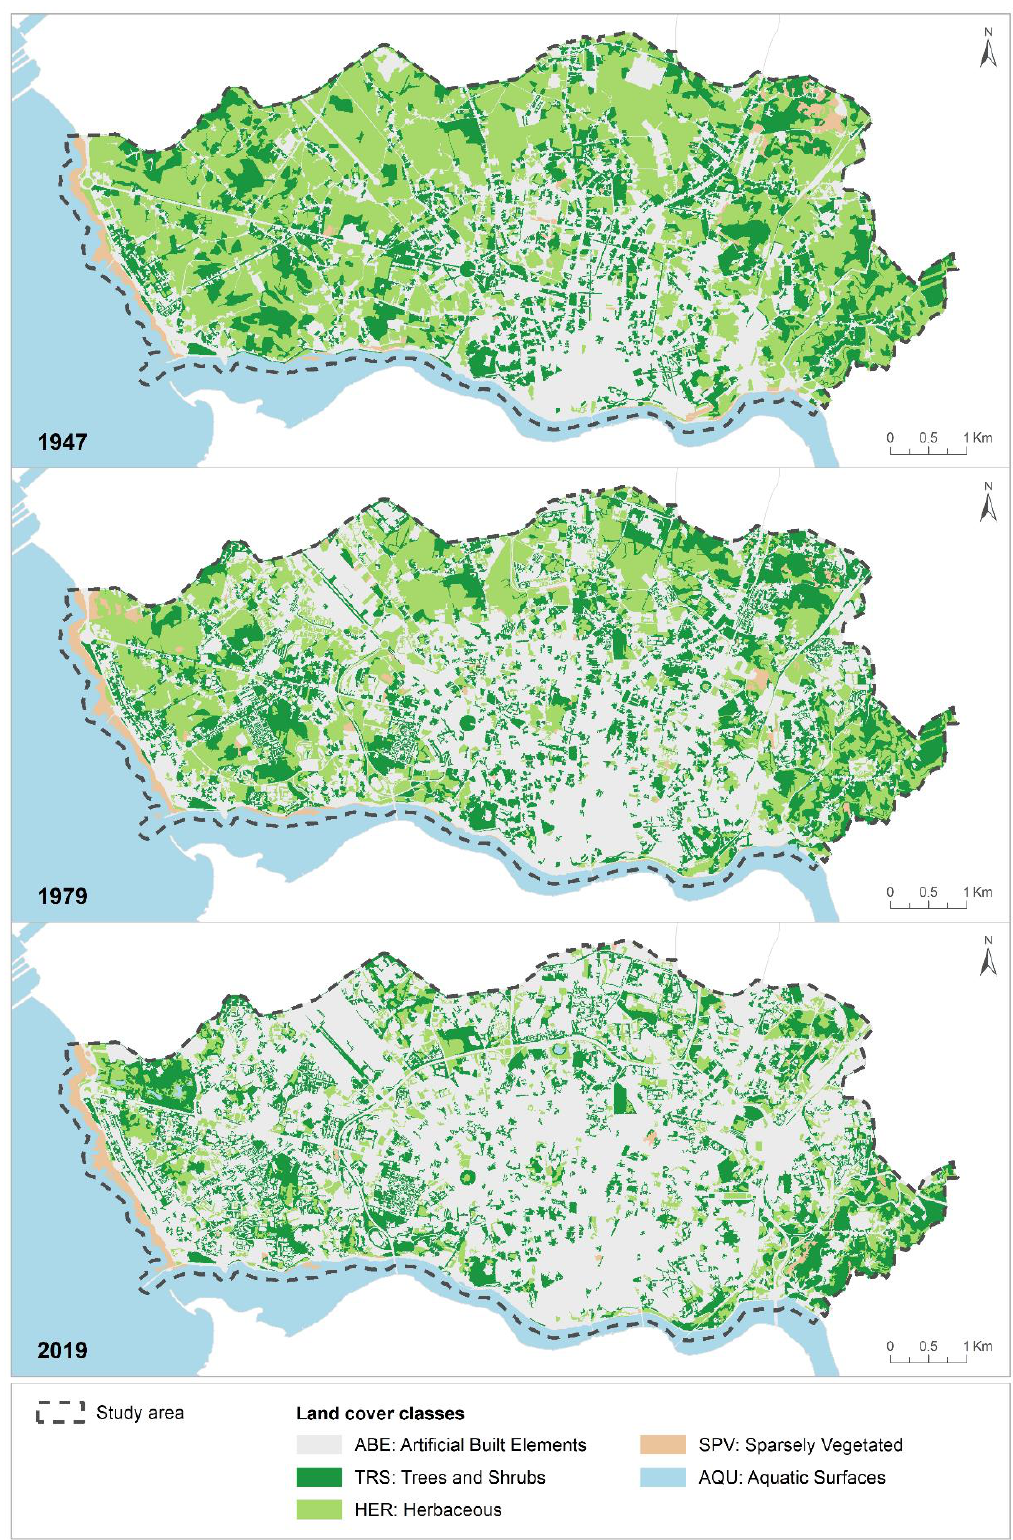
Figure 4. Land cover maps of Porto in 1947, 1979, and 2019.